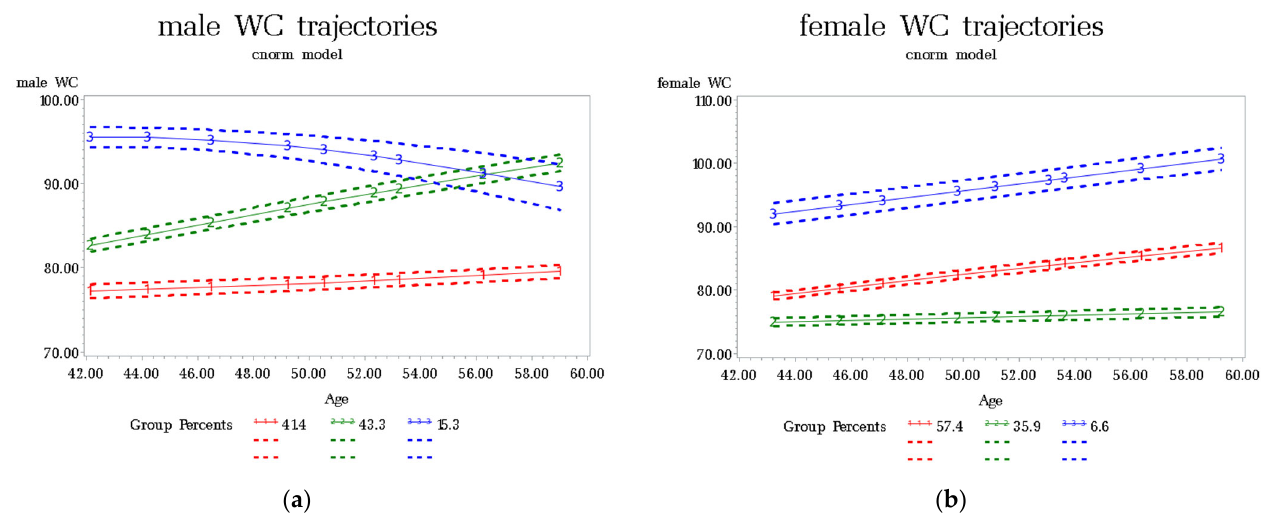
Figure 1. Estimated trajectory groups of WC among males ( a ) and females ( b ). Note: In male, the red line represents the “normal ‐ stable group”, the green line represents the “normal ‐ increase to central obesity group”, the blue line represents the “central obesity ‐ slight decrease group”. In female, the red line represents the “normal ‐ increase to central obesity group”, the green line represents the “normal ‐ stable group”, the blue line represents the “central obesity ‐ increase group”.